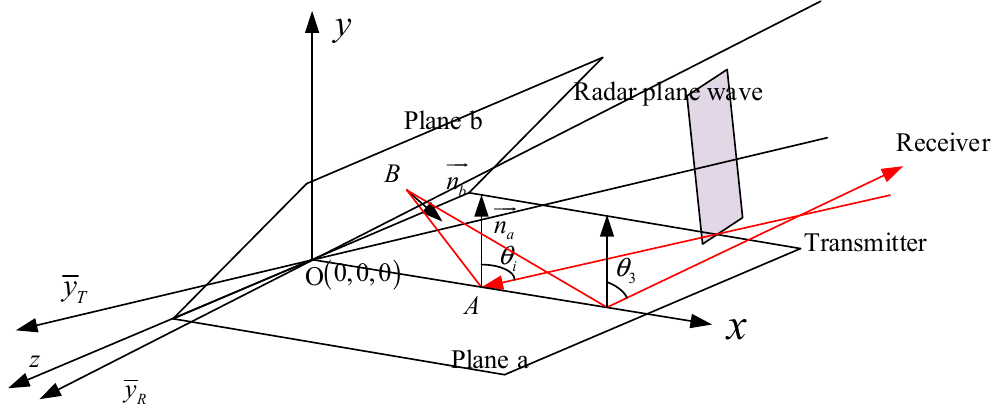
Figure 4. Three-bouncing reflection path of an acute dihedral corner case.